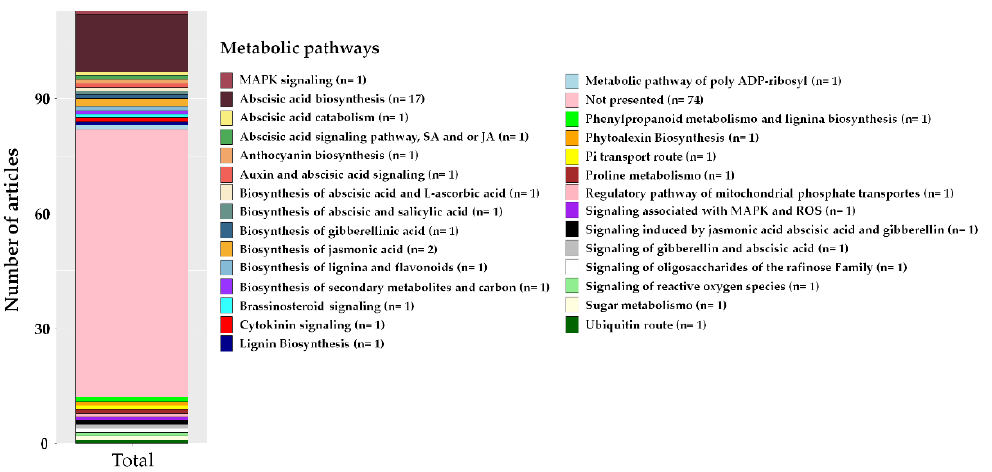
Figure 8. Metabolic pathways reported in the articles on CRISPR/Cas-associated gene editing for tolerance to abiotic stresses published in the last seven years, n = number of articles.